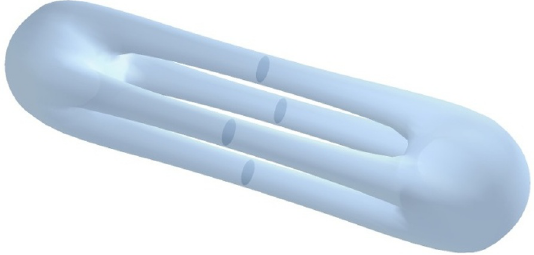
Figure 6 . A handlebody with a genus-3 asymptotic boundary. Each shaded disk shown should be associated with a Hilbert space of the boundary graviton states which form the representation of the Virasoro algebra with c = 1 =